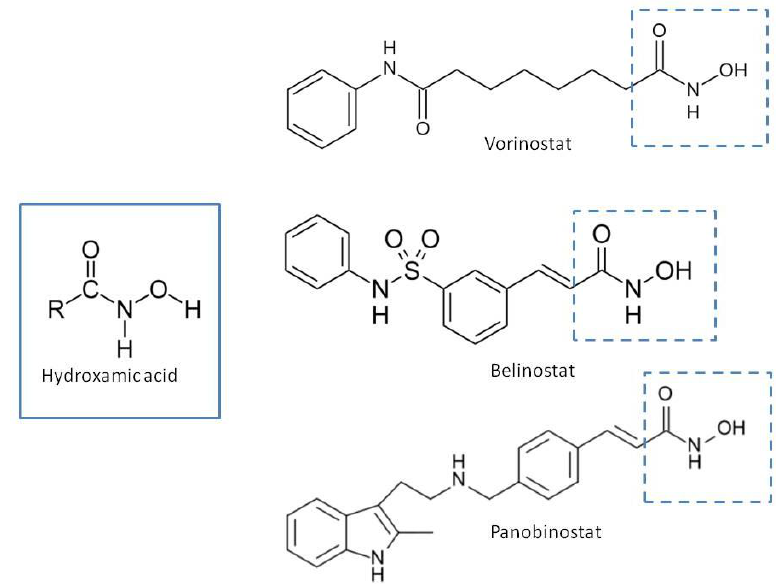
Figure 1. Chemical structures of Hb-HDACIs. Three different Hb-HDACIs, vorinostat, belinostat and panobinostat, are depicted in their planar formulae. The hydroxamic acid group, which characterizes this class of HDACIs, is represented in the square. It is responsible for the binding of these compounds to the zinc ion located into the catalytic domain of the enzyme.